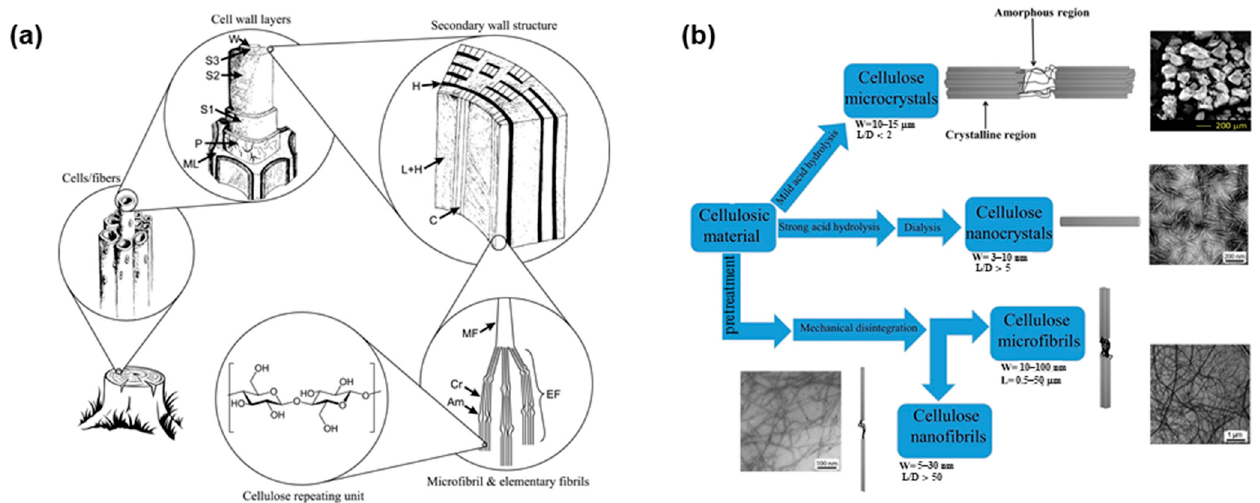
Figure 3. ( a ) Hierarchical structure of wood, showing: the middle lamella (ML), the primary wall (P), the outer (S1), middle (S2), and inner (S3) layers of secondary wall, the warty layer (W), cellulose (C), hemicellulose (H), lignin (L), microfibril (MF), elementary fibril (EF), crystalline domain (Cr) and amorphous domain (Am) [65]; ( b ) Methods to manufacture cellulose fibers with various sizes [17].